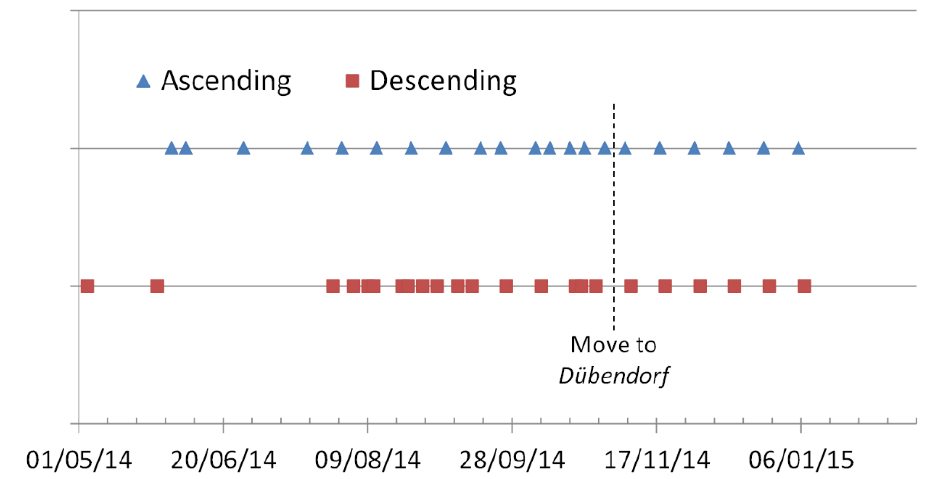
Figure 3. S1A StripMap acquisition time series over Torny-le-Grand and Dübendorf